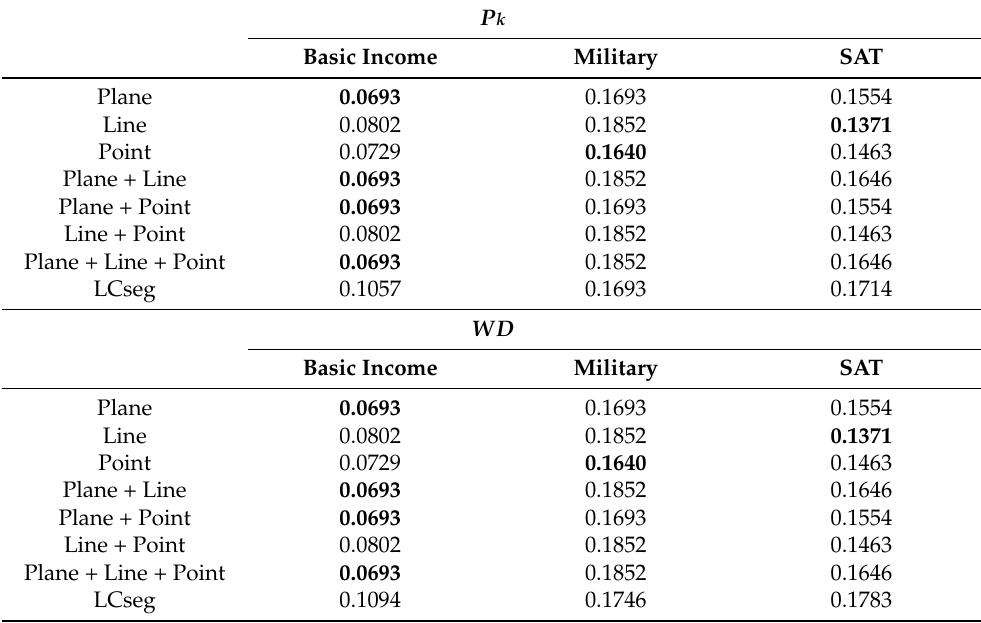
Table 6. CSseg P k and WD values with the weight of chain of arguments and counterarguments set to 2.